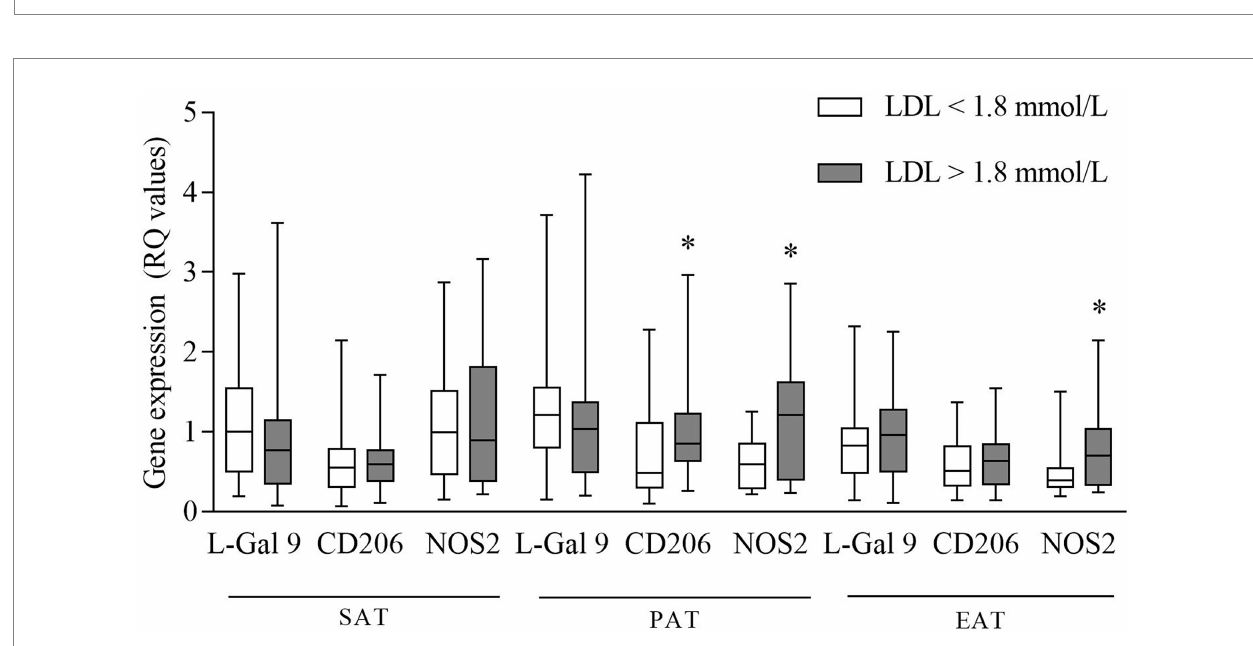
FIGURE 4 Gene expression of L-Gal 9, CD206, and NOS2 in CHD patients with LDL-C levels below and above the median value (1.8 mmol/L). Data are reported as RQ values and box plots indicate the median values, 25th and 75th percentiles, while error bars report 10th and 90th percentiles. Mann–Whitney U -test was applied and a value of p < 0.05 was considered statistically significant. Above median vs. below median: PAT: higher expression of CD206 and NOS2. In EAT: higher expression of NOS2. * p <